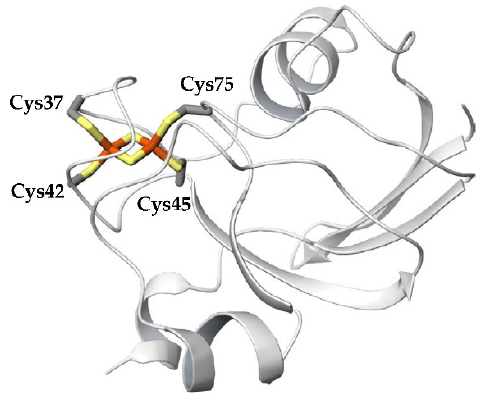
Figure 2. Overall structure of plant-type Fd. [2Fe‒2S] cluster and ligated Cys residues are presented as licorice.